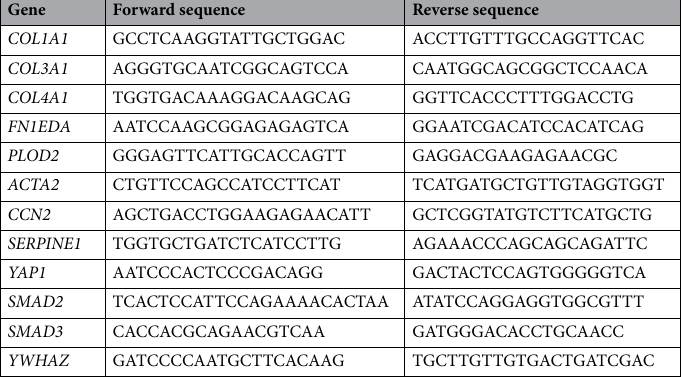
Target Company Mouse anti-human collagen type I Mouse anti-human α-smooth muscle actin (α-SMA)